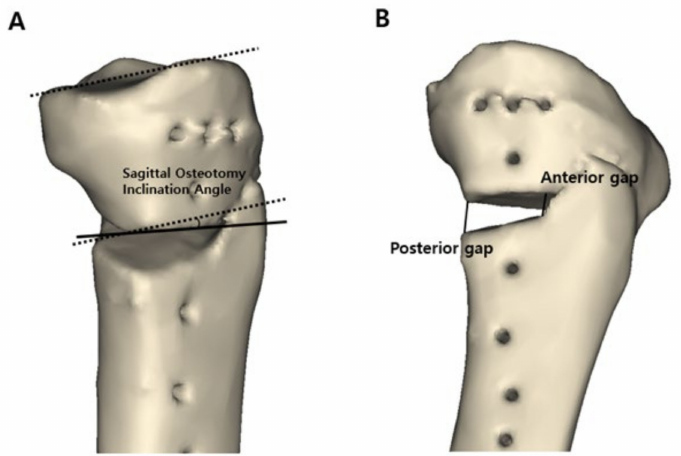
Figure 3. Measurement of the sagittal osteotomy inclination angle and anterior and posterior opening gap in a three-dimensional reconstructed model. ( A ) The sagittal osteotomy inclination angle was measured as the angle formed by the medial tibial plateau line (black dotted line) and osteotomy line on the anteromedial aspect of the lowermost part of the proximal tibial segment (black solid line) on the true lateral view. ( B ) Distances of anterior opening gap and posterior opening gap were measured in the three-dimensional reconstructed model. The anterior opening gap was measured at the medial edge of the frontal plane osteotomy site. The posterior opening gap was measured at the most prominent posteromedial edge of